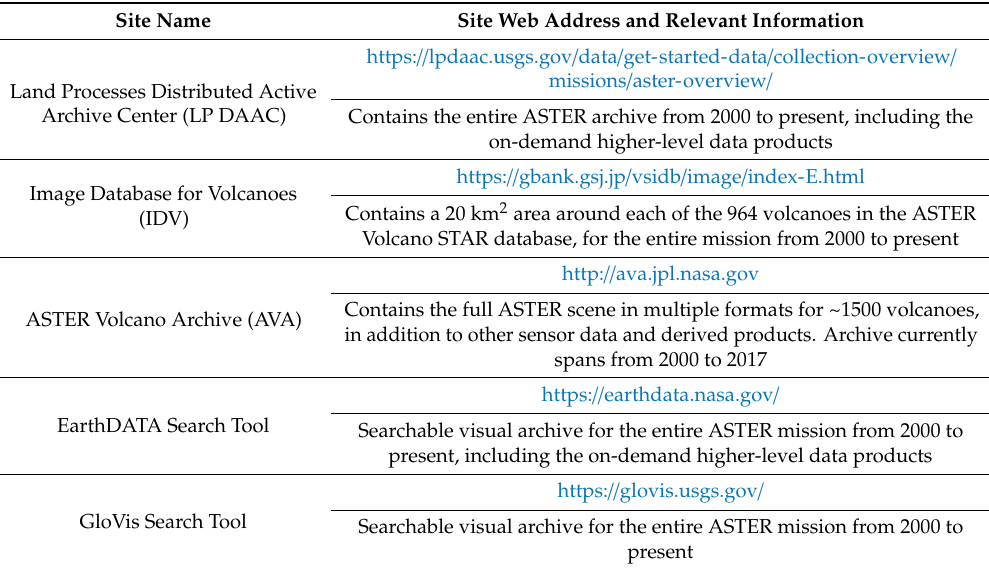
Table 1. Volcano-specific data archives and search tools available for all ASTER